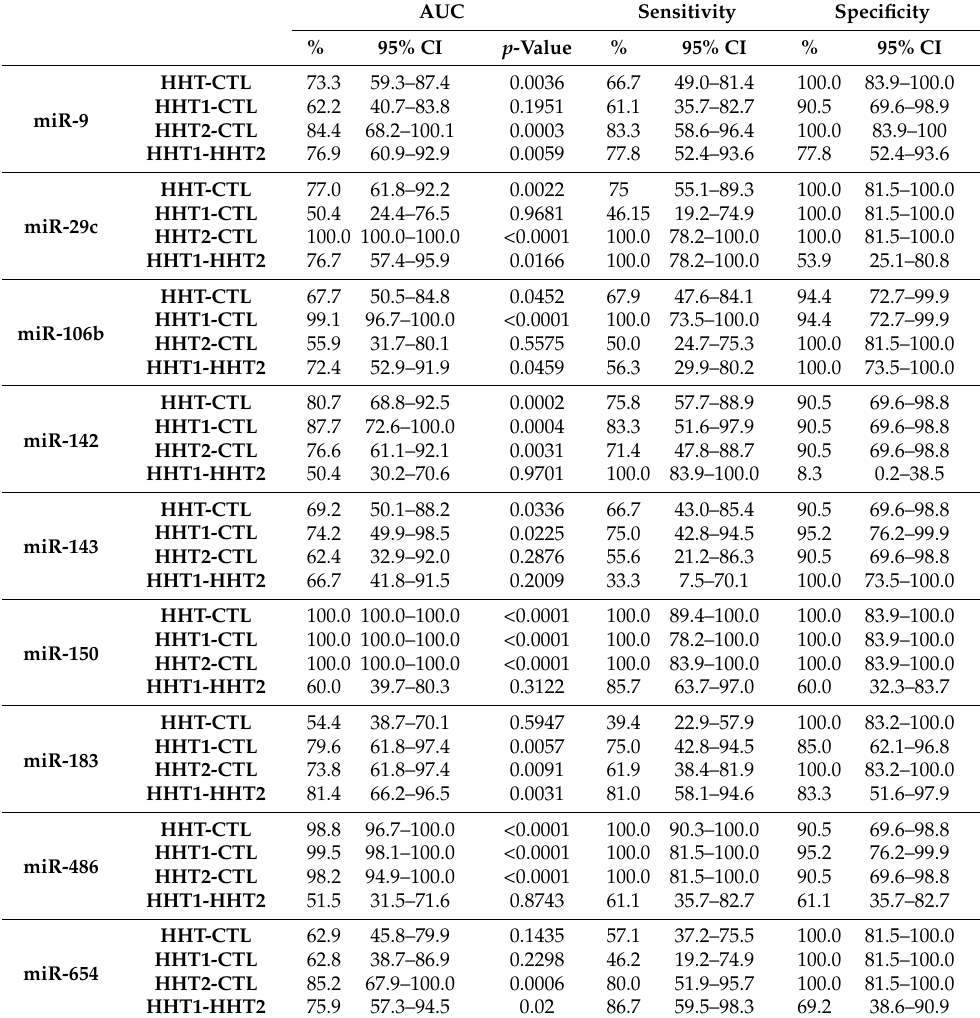
Table 2. The diagnostic efficiency of the miRNA signature. The area under the ROC curve (AUC) was used to gauge and compare biomarkers’ (miRNAs) performance, classifying the biomarkers as good (yellow, 90% < AUC < 75%) and excellent (green, AUC > 90%). Sensitivity and specificity are indicated. All values are shown together with their corresponding confidence interval (95%